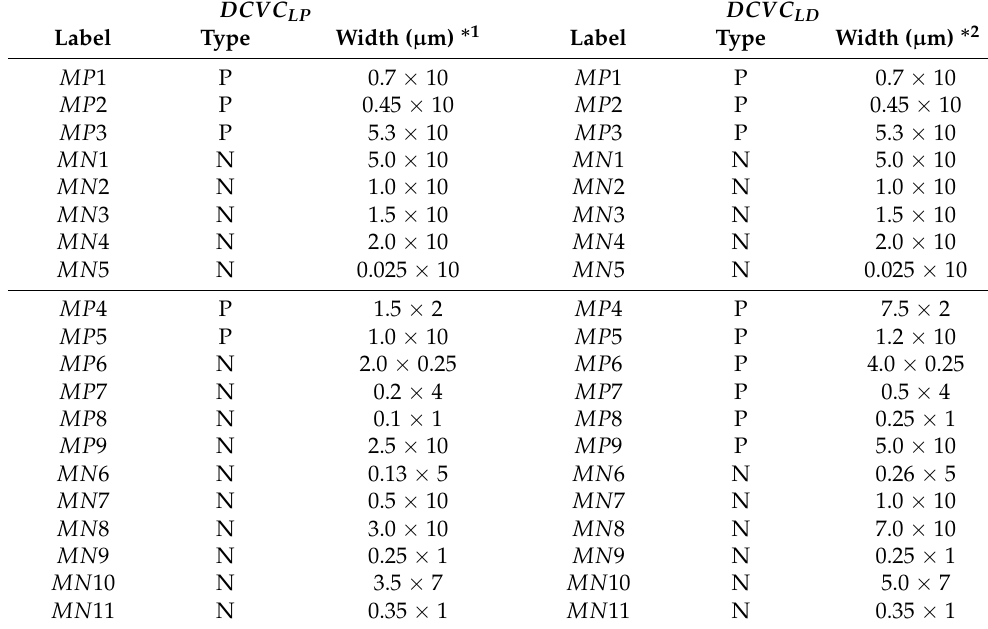
Table 1. Sizing of PMOS and NMOS transistors.